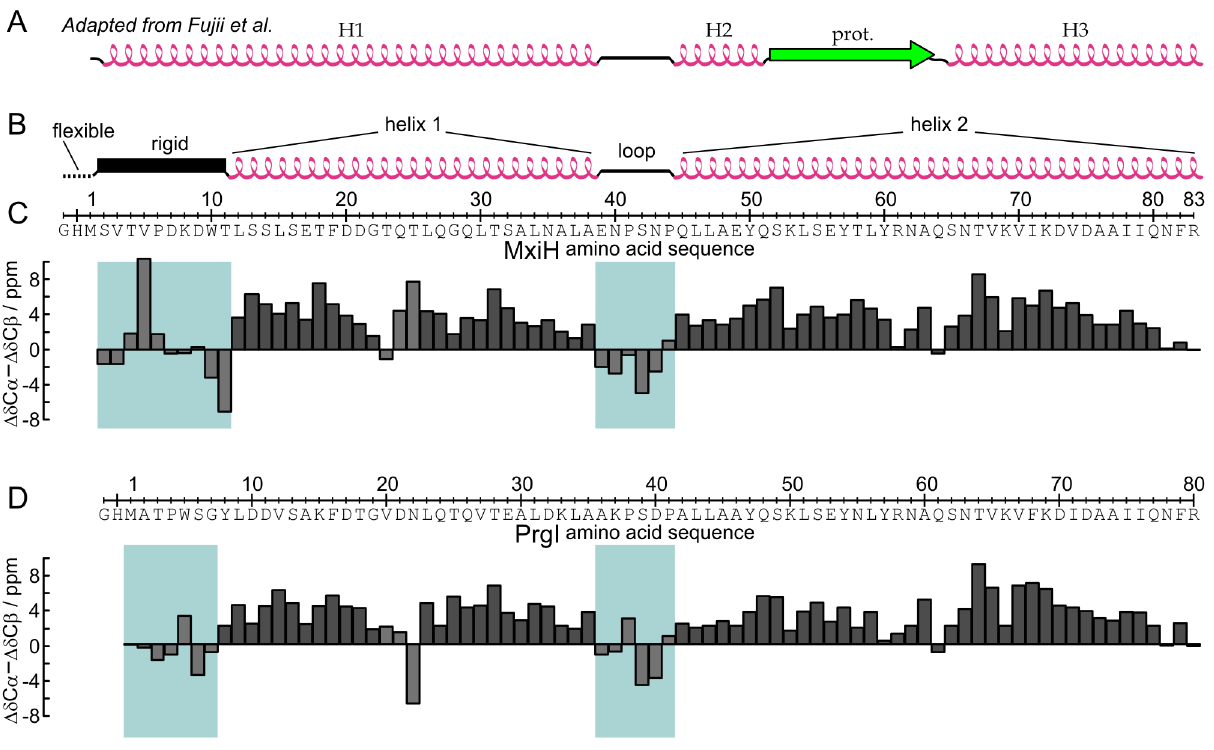
Figure 4. Identification of secondary structure elements. A , Secondary structure elements identified in the cryoEM model of Fujii et al. ; adapted from Fig. 1e in Ref. [19] where H1, H2, and H3 indicate the position of a -helices and ‘‘prot’’ that of the b -hairpin between H2 and H3. B , Secondary structure elements of MxiH needles determined by solid-state NMR (this study). C , Secondary chemical shifts ( Dd C a – Dd C b ) of the Shigella flexneri MxiH protein in the assembled needle. Regions which do not present a -helical propensity are highlighted. D, Secondary chemical shifts of the Salmonella tympimurium PrgI protein in the assembled needle taken from Ref. [37].